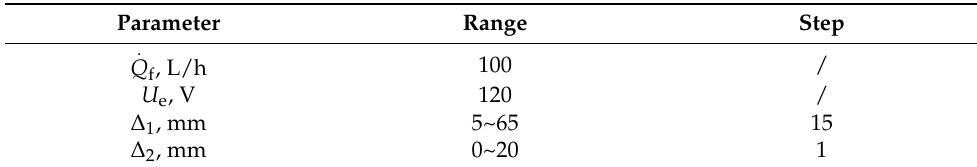
Δ on I ; ( b ) effect of ∆ 2c on I 2a